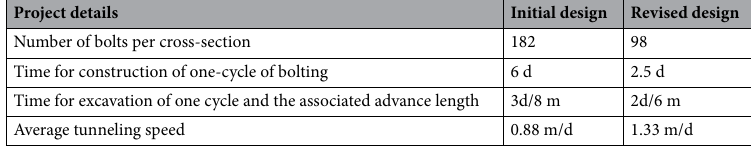
Table 5. Comparison of the construction time for the initial design and the revised design.